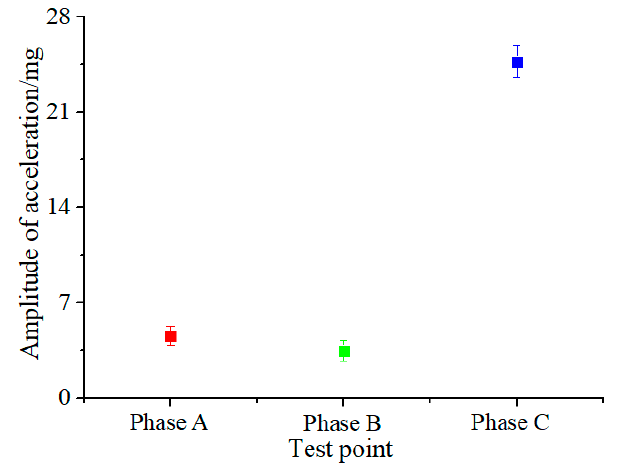
Figure 18. Comparison of acceleration.